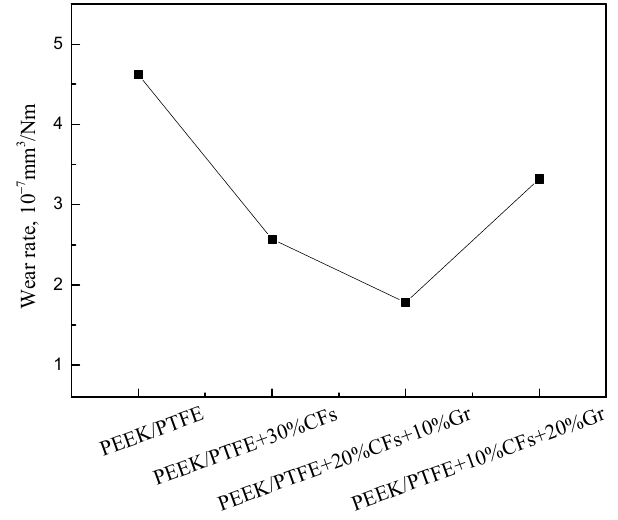
Figure 3. Wear rates of PEEK/PTFE composites reinforced with different contents of CFs and Gr.